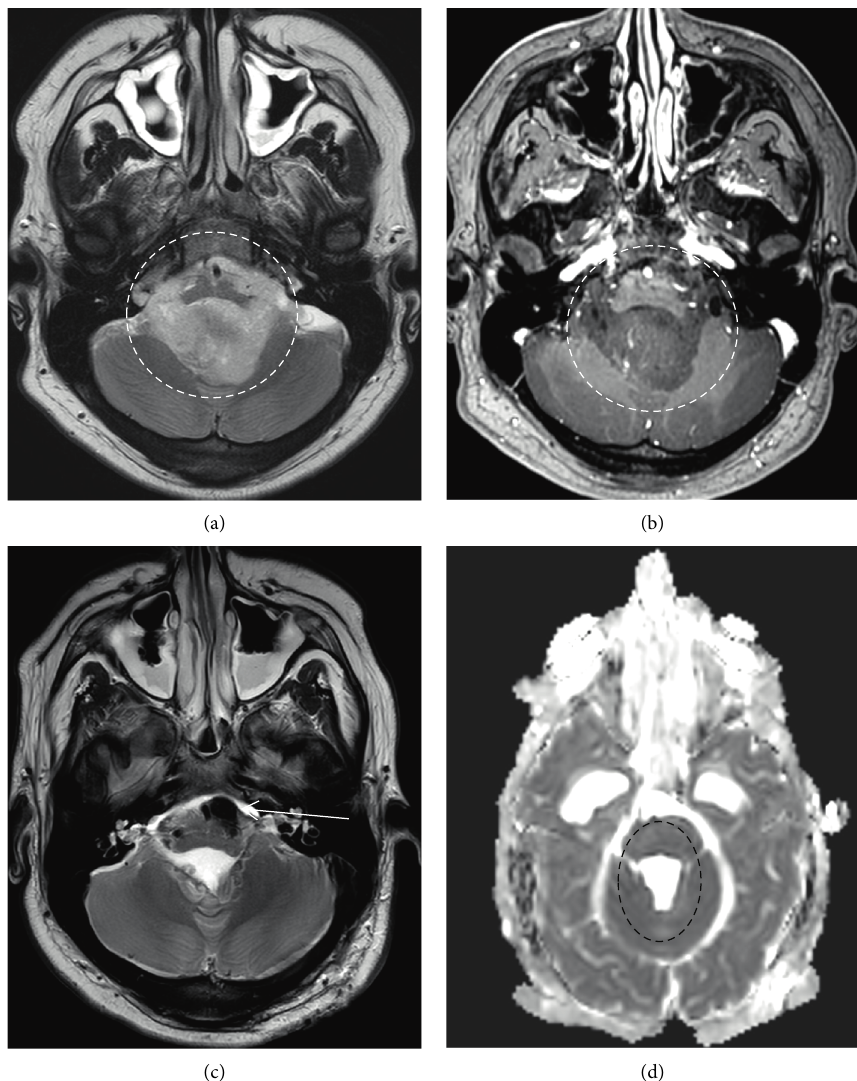
Figure 1: Axial T2 weighted (a) and T1 post-contrast (b) images demonstrating the 4th ventricular tumour (white circle). Axial T2 weighted image (c) following surgery demonstrating susceptibility artefact due to air in the surgical field (white arrow). (d) Complete resection of the tumour with no evidence of diffusion abnormality involving the proximal efferent cerebellar structures on the ADC image (black